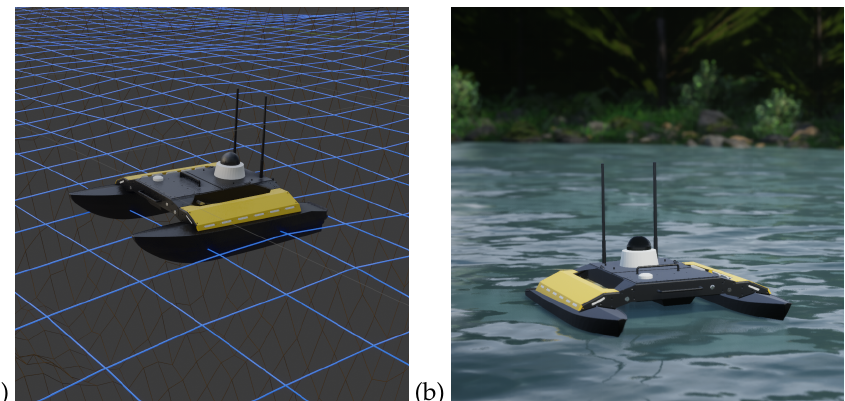
Figure 15. Robotic boat ( a ) “Elisabeth” within the virtual environment. Movements of the water surface are implemented through displacement maps and shrink-wrap modifiers. Color textures ( b ) enable possibilities for accurate renderings for visualization